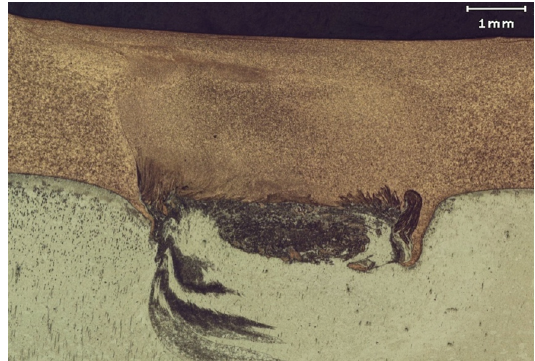
Figure 9. Copper-aluminium interface on a lap joint welded at WD